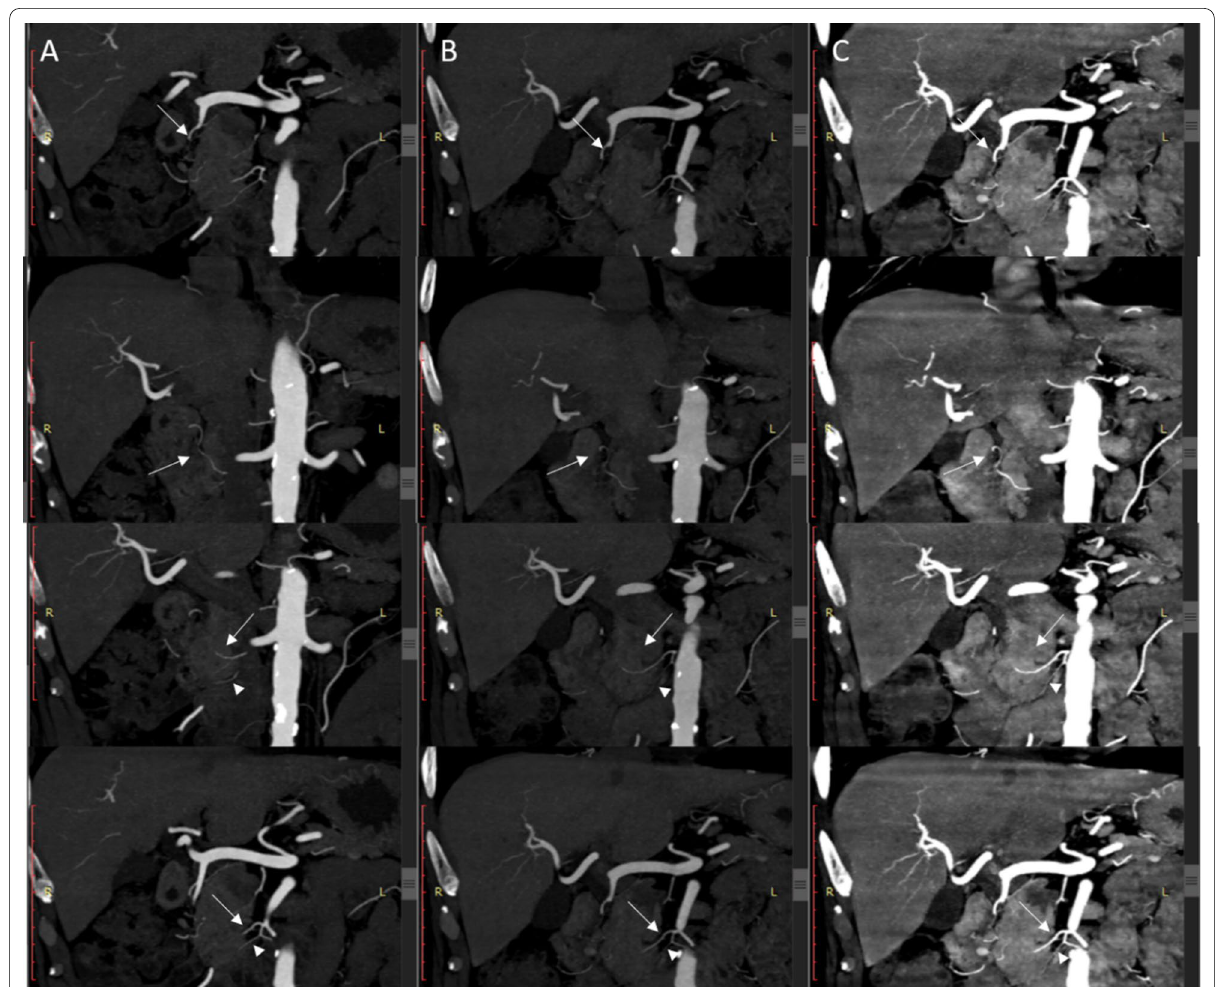
Fig. 2 Depiction of pancreatic arteries in ND‑CM, LD‑CM, and VMI patient who underwent ND‑CM (0.8 mL/kg, 400 mgI/mL, and 320 mgI/kg), LD‑CM (0.56 mL/kg, 400 mgI/mL, and 224 mgI/kg), and VMI using the same window level (300 HU) and width (600 HU). The CT value of the aorta was highest on VMI images ( a ), and lowest on LD‑CM images ( b ). The posterior pancreaticoduodenal artery arch (white arrow) can be depicted clearly on all images. The anterior inferior pancreaticoduodenal artery (AIPDA) (arrowhead) on LD‑CM images ( b ) cannot be seen clearly, which showed a faint display on VMI LD‑CM images ( c ) and can be seen clearly on ND‑CM images ( a ). ND-CM normal‑dose contrast medium, LD-CM low‑dose contrast medium, + VMI